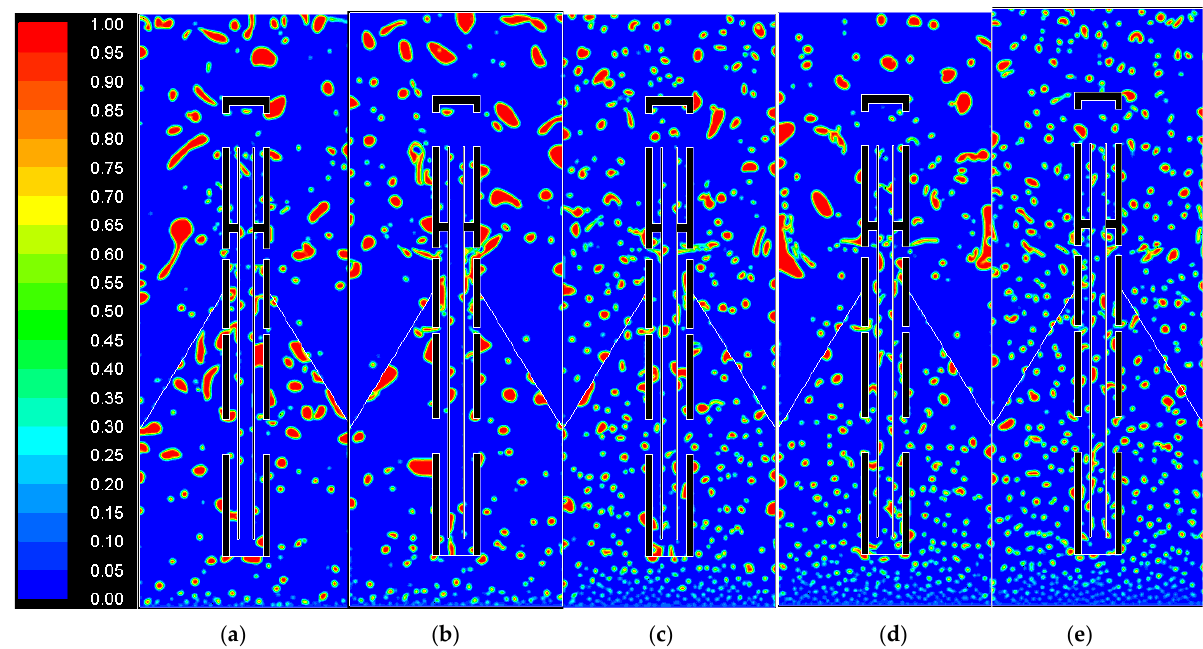
Figure 7. Cloud diagram of oil phase distribution of gas–oil–water with total flow at ( a ) 20 m 3 /d; ( b ) 30 m 3 /d; ( c ) 40 m 3 /d; ( d ) 50 m 3 /d; ( e ) 60 m 3 /d. Table 5. Gas–liquid separation efficiency at oil–gas–water multiphase flow.